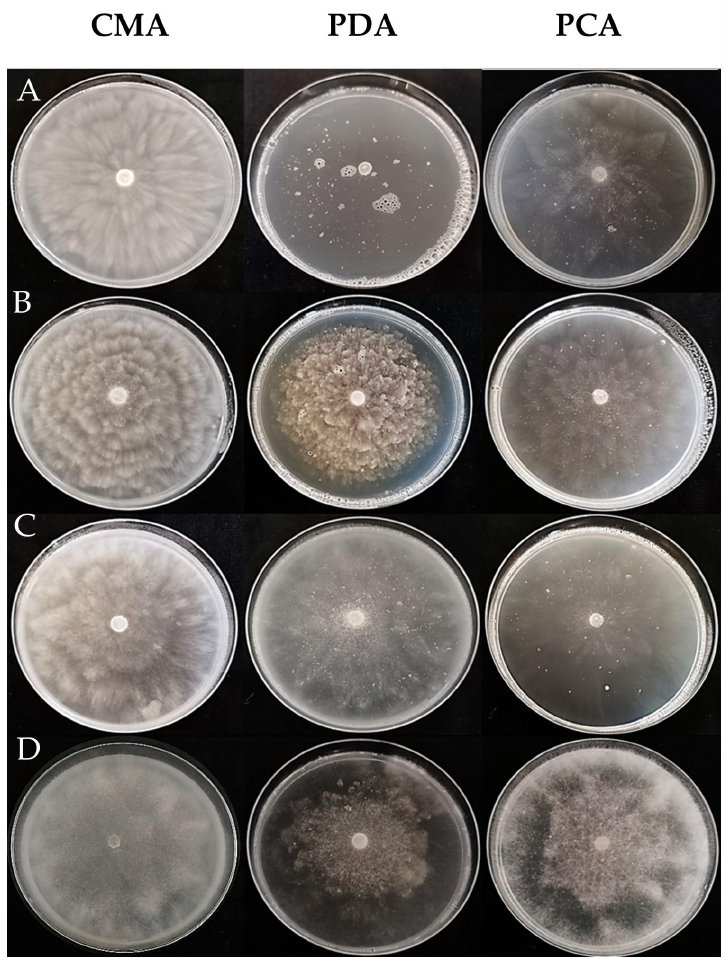
Figure 3. Colony morphology of Phytopythium species isolated from kiwifruits on Corn Meal Agar (CMA), Potato Dextrose Agar (PDA) and Potato Carrot Agar (PCA) after 6 days at 25 ± 1 °C. ( A ) Phytopythium vexans; ( B ) Phytopythium litorale ; ( C ) Phytopythium chamaehyphon ; ( D ) Phytopythium helicoides . The optimal growth for P. chamaehyphon strains occurred at 25 ◦ C on CMA, PDA